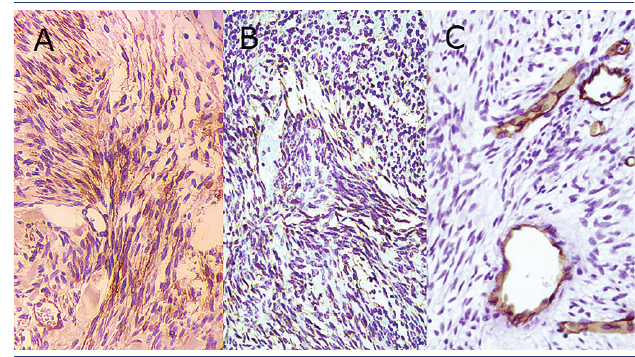
figurE 4 − Photomicrographs showing neoplastic cells positive for actin antibodies (A), vimentin (B), and negative for CD31 (C). Immunohistochemical reaction – DAB stain – magnification 400× in A and C, and 200× in B DAB: 3,3’-diaminobenzidine